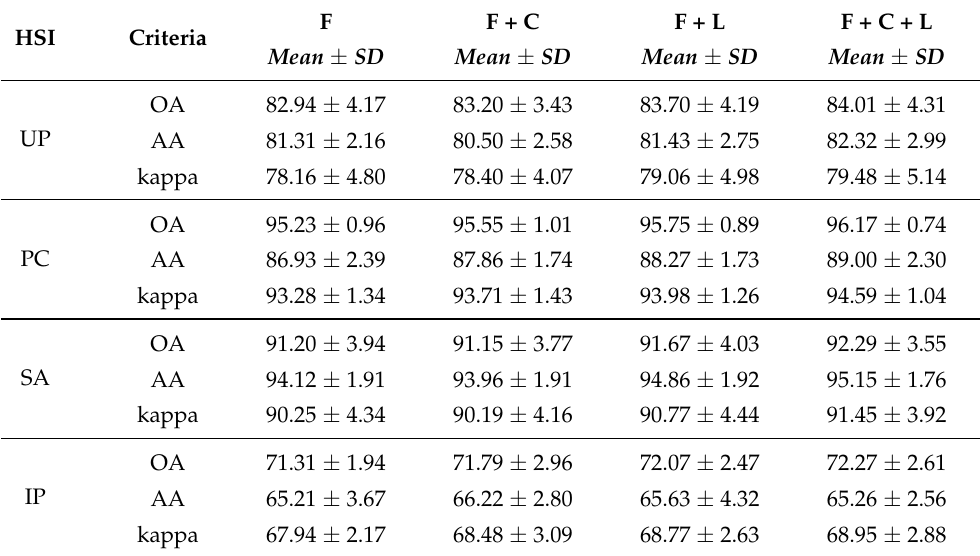
Table 4. The results of the proposed method with different distillation levels. The channel-, feature- and logit-level are denoted as C, F and L, respectively. SD denotes the standard deviation of 10 exper- imental